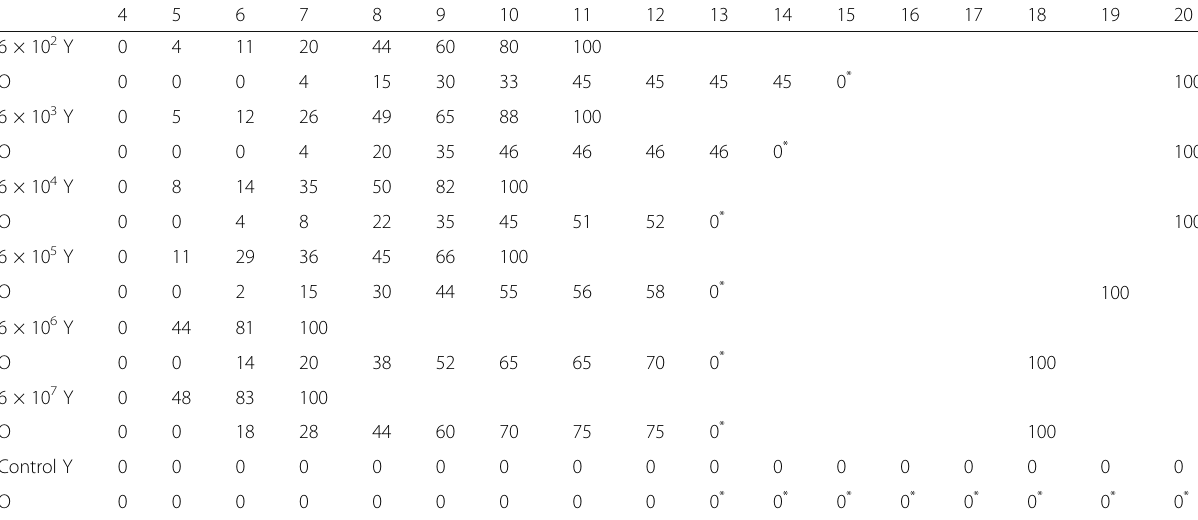
Table 1 Mortality % among larvae of the RPW R. ferrugineus treated with different concentrations of B. bassiana conidiospores and resulted pupae